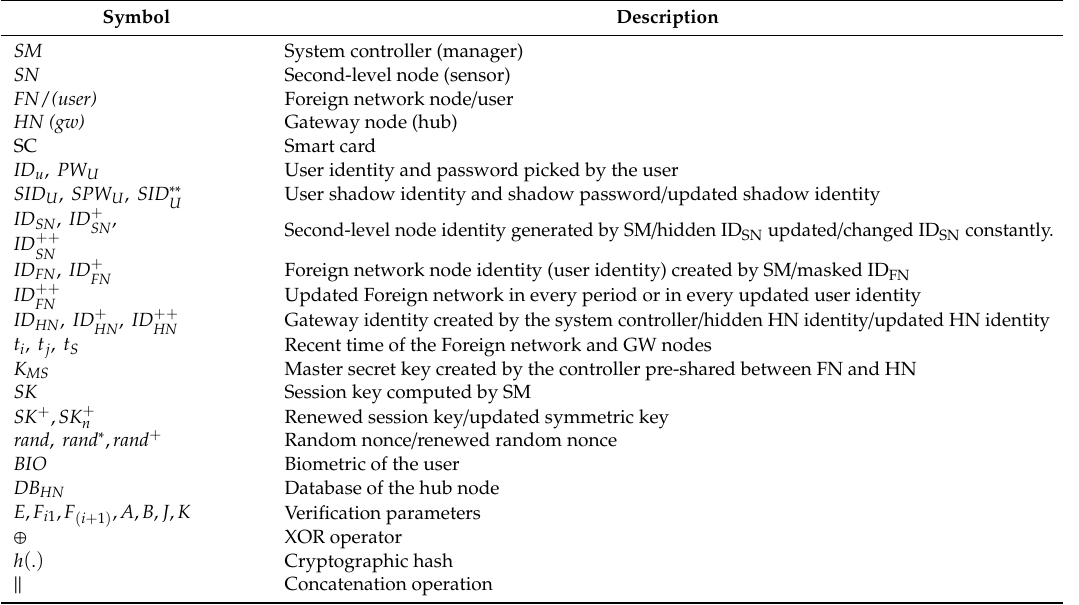
Table 2. Notations of the